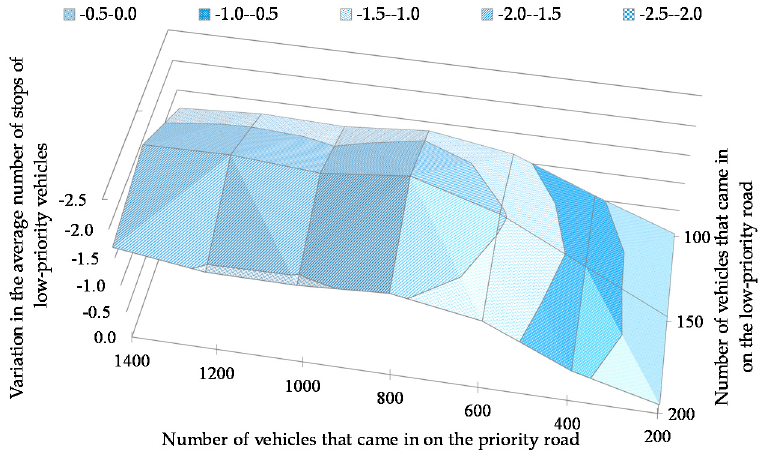
Figure 12. Variation in the average number of stops of low-priority vehicles when the number of vehicles coming in was varied. The average number of stops was the average for the entire percentage range of self-driven vehicles.